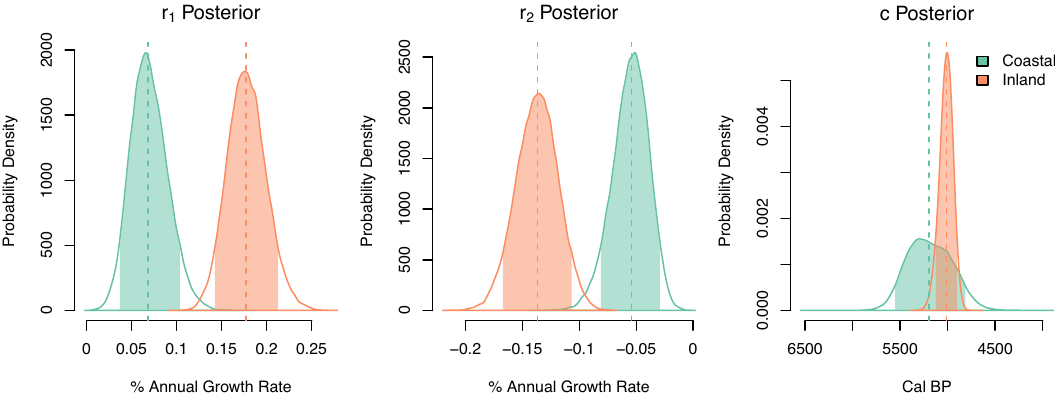
Figure 2. Marginal posterior distribution of growth rates r 1 and r 2 and change-point c for the inland and coastal radiocarbon dates. Highlighted regions depict the 90% higher posterior density interval. Figure generated using R v4.1.0 (https:// www.r- proje ct.